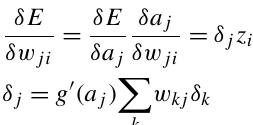
Figure 7. ROC graph with an example of classifier